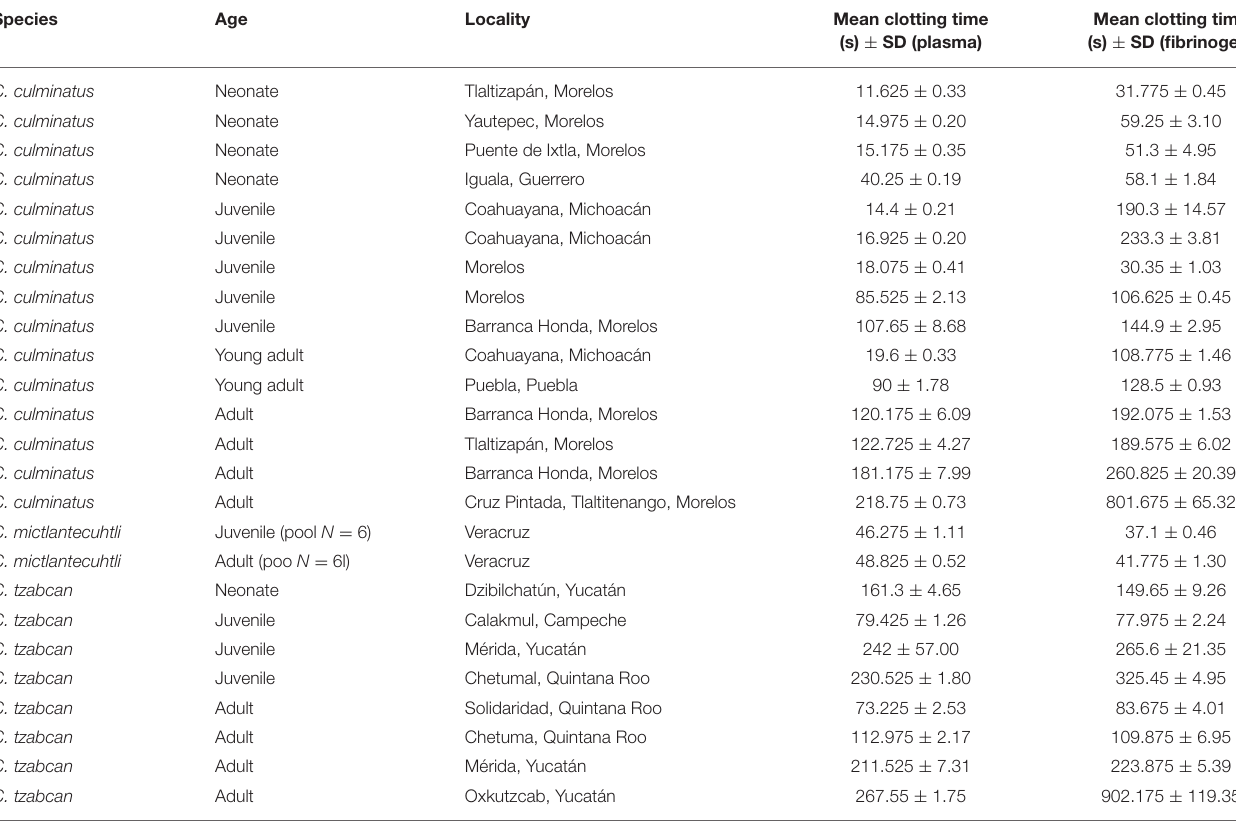
TABLE 2 | Clotting times of human plasma and fibrinogen incubated with venoms from C. culminatus , C. mictlantecuhtli , and C. tzabcan specimens. Species